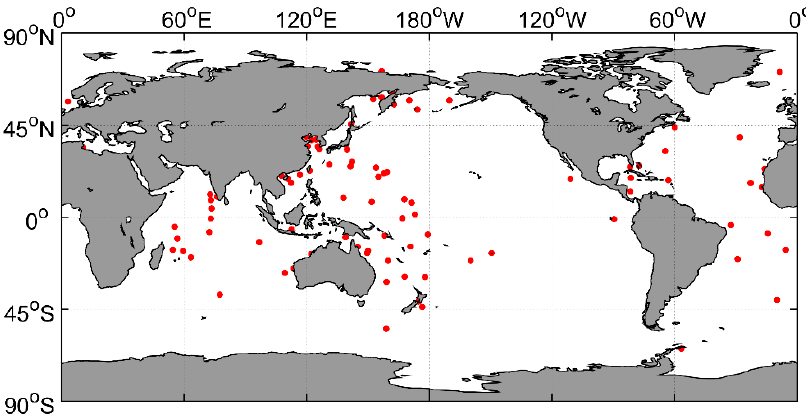
Figure 2. Locations of the radiosonde stations. The red dots indicate the positions of the radio-